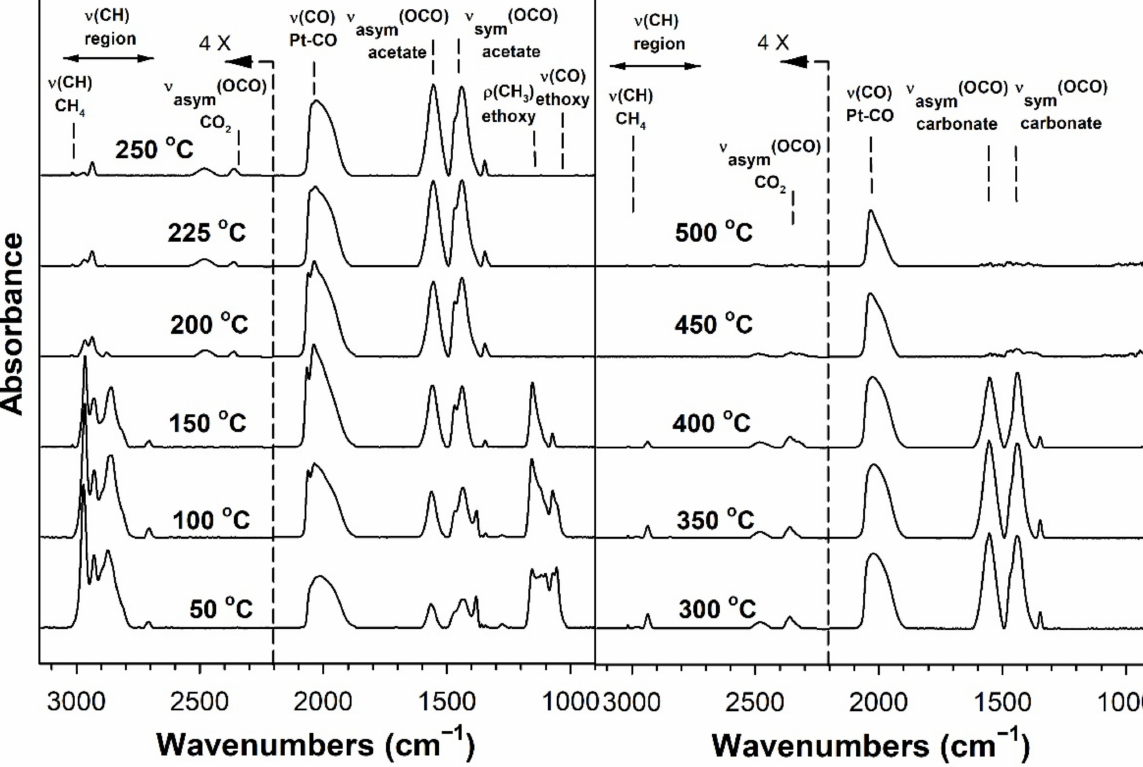
Figure 8. DRIFTS spectra of transient ESR over 2% Pt/m-ZrO 2